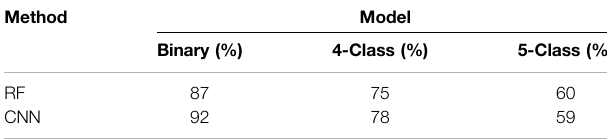
TABLE 3 | Testing accuracy results of RF and CNN on all three models. Method